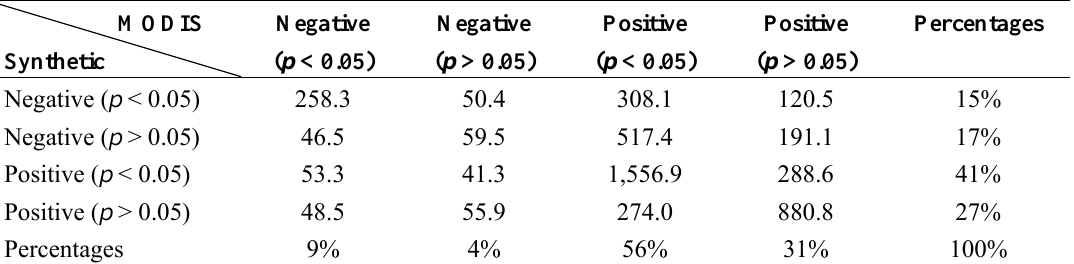
Table 3. Cross-tabulation considering the significance of NDVI trends derived from the synthetic and MODIS dense time series (2000–2011). Chi-square test of the cross-tabulation showed a significant ( p < 0.001) relationship between the two trend maps with a contingency coefficient of 0.56 out of 0.86 (values in km 2